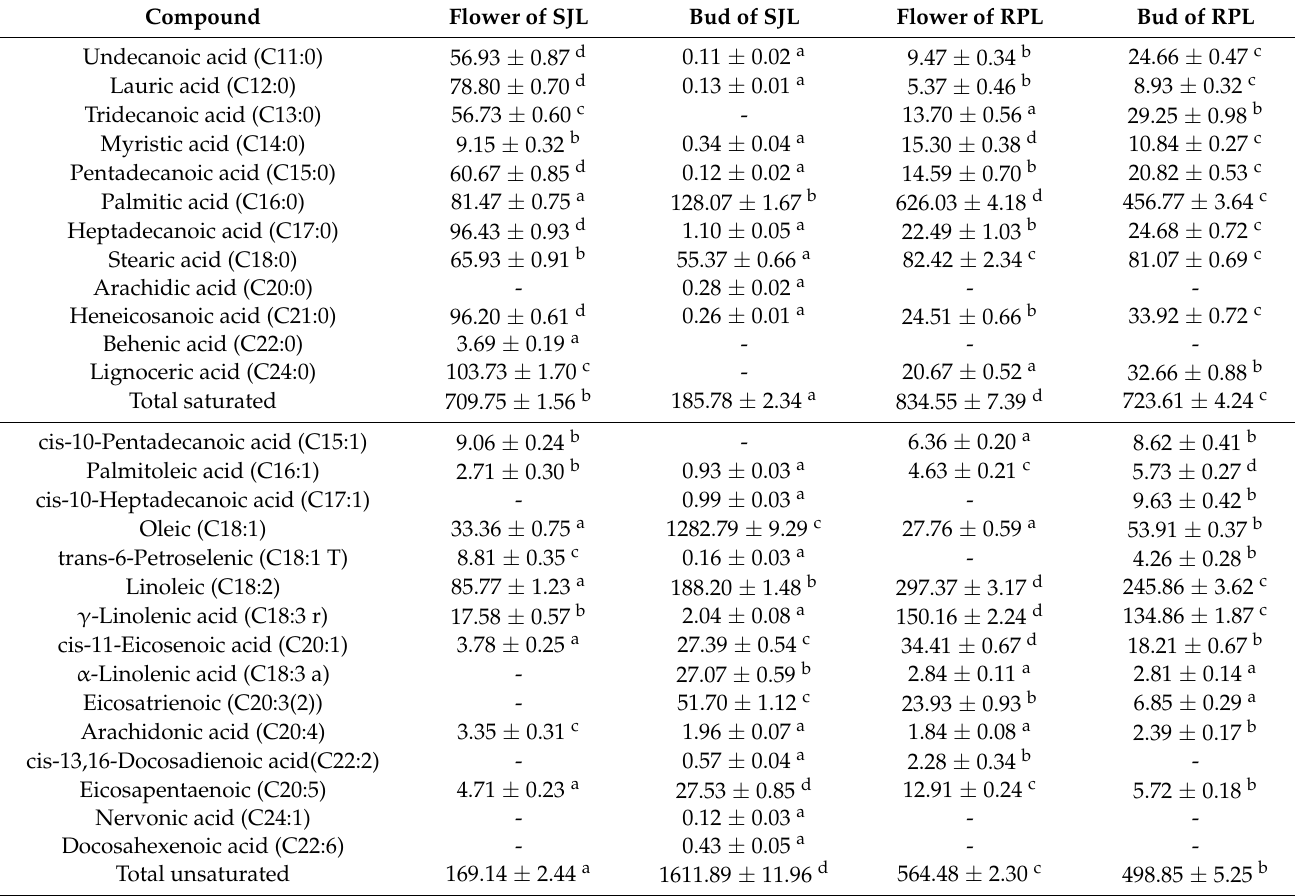
Table 2. Fatty acid content of SJL and RPL (mg/kg